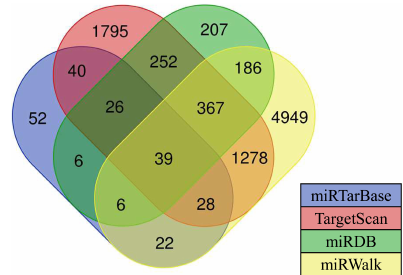
Figure 4. Various types of software for predicting the target genes of miRNAs. The numbers in the intersection of the four circles refer to the candidate target genes of